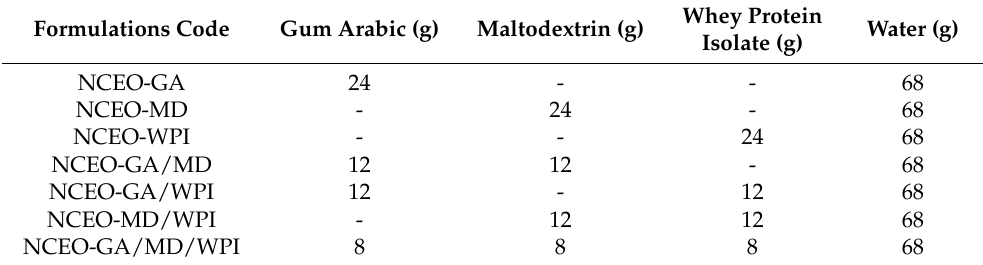
Table 1. Formulation of the aqueous phase of Citrus reticulata essential oil nanoemulsions. Formulations